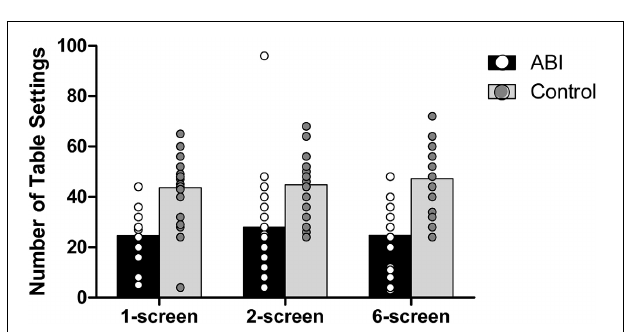
FIGURE 10 | Average time per place setting in seconds.